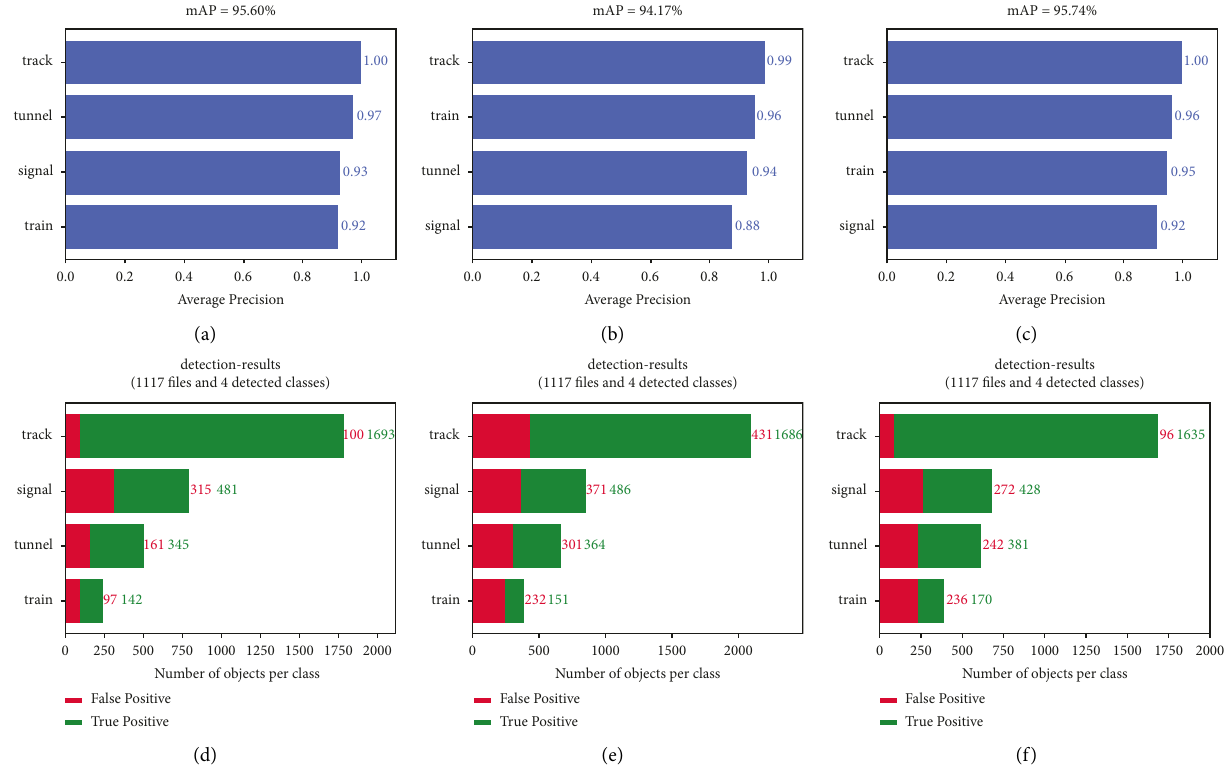
Figure 11: MYOLO-lite series model prediction results. (a) MV1-YOLO-lite mAP. (b) MV2-YOLO-lite mAP. (c) MV3-YOLO-lite mAP. (d) MV1-YOLO-lite prediction result. (e) MV2-YOLO-lite prediction results. (f) MV3-YOLO-lite prediction results. Table 3: Comparison of AP values of different network models for four types of objects. Detection algorithm